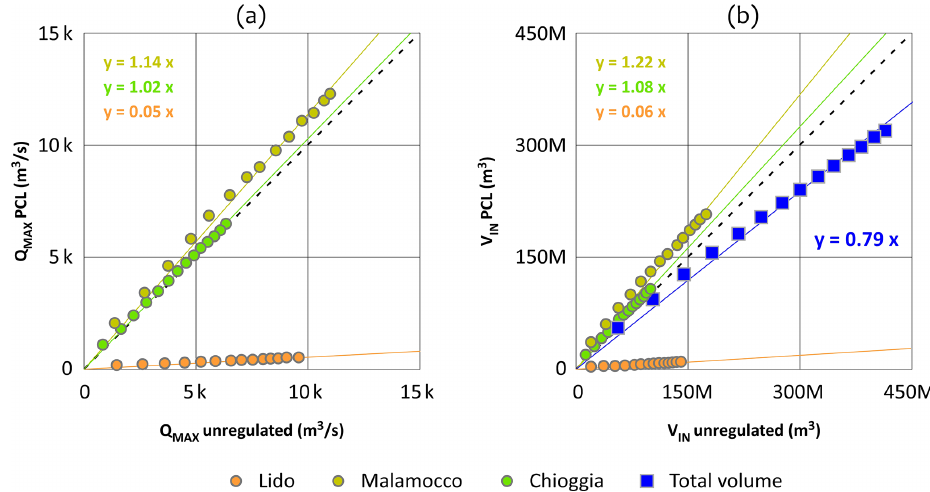
Figure 7. Sinusoidal tide, no wind (scenario I). Tidal range from 0.1 to 1.4m and period of 6h. Comparison of maximum flow rate (a) and water volume entering the lagoon (b) at the three inlets during the flood tide ( x axes unregulated lagoon; y axes